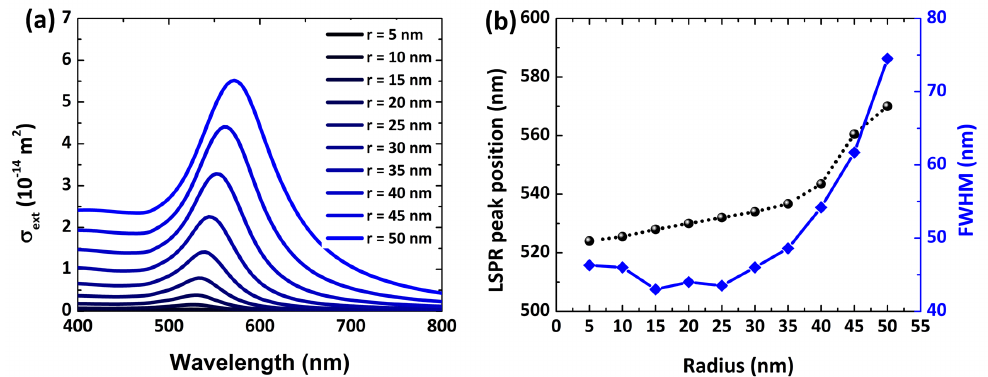
Figure 4. ( a ) LSPR spectral plasmonic resonance and ( b ) peak resonance wavelengths (black spheres) along with FWHM (blue cubes) as a function of particle radius. The radius parameter is tuned from 5 nm to 50 nm with a step of 5 nm, while keeping the surrounding medium constant (n =